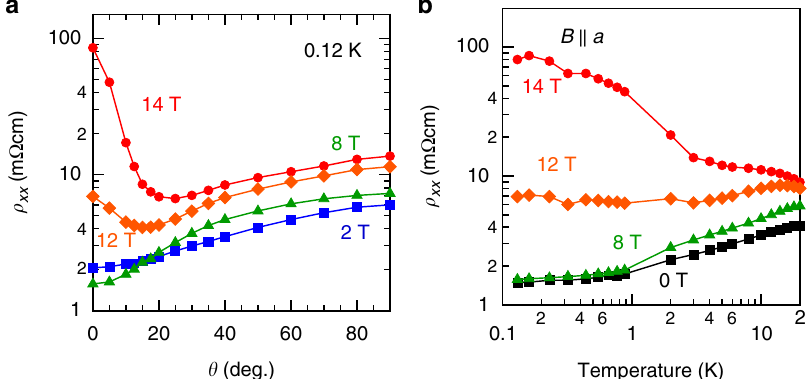
Fig. 4 Angular and temperature dependence of giant magnetoresistivity. a The resistivity at various magnetic fi elds vs. θ at 0.12 K. b Temperature dependence of resistivity for B || a